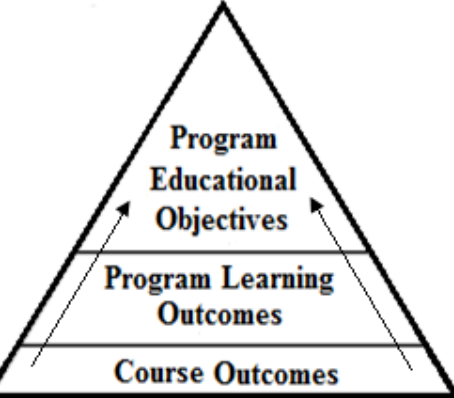
Figure 1. PEOs, PLOs, COs, and their correlations.